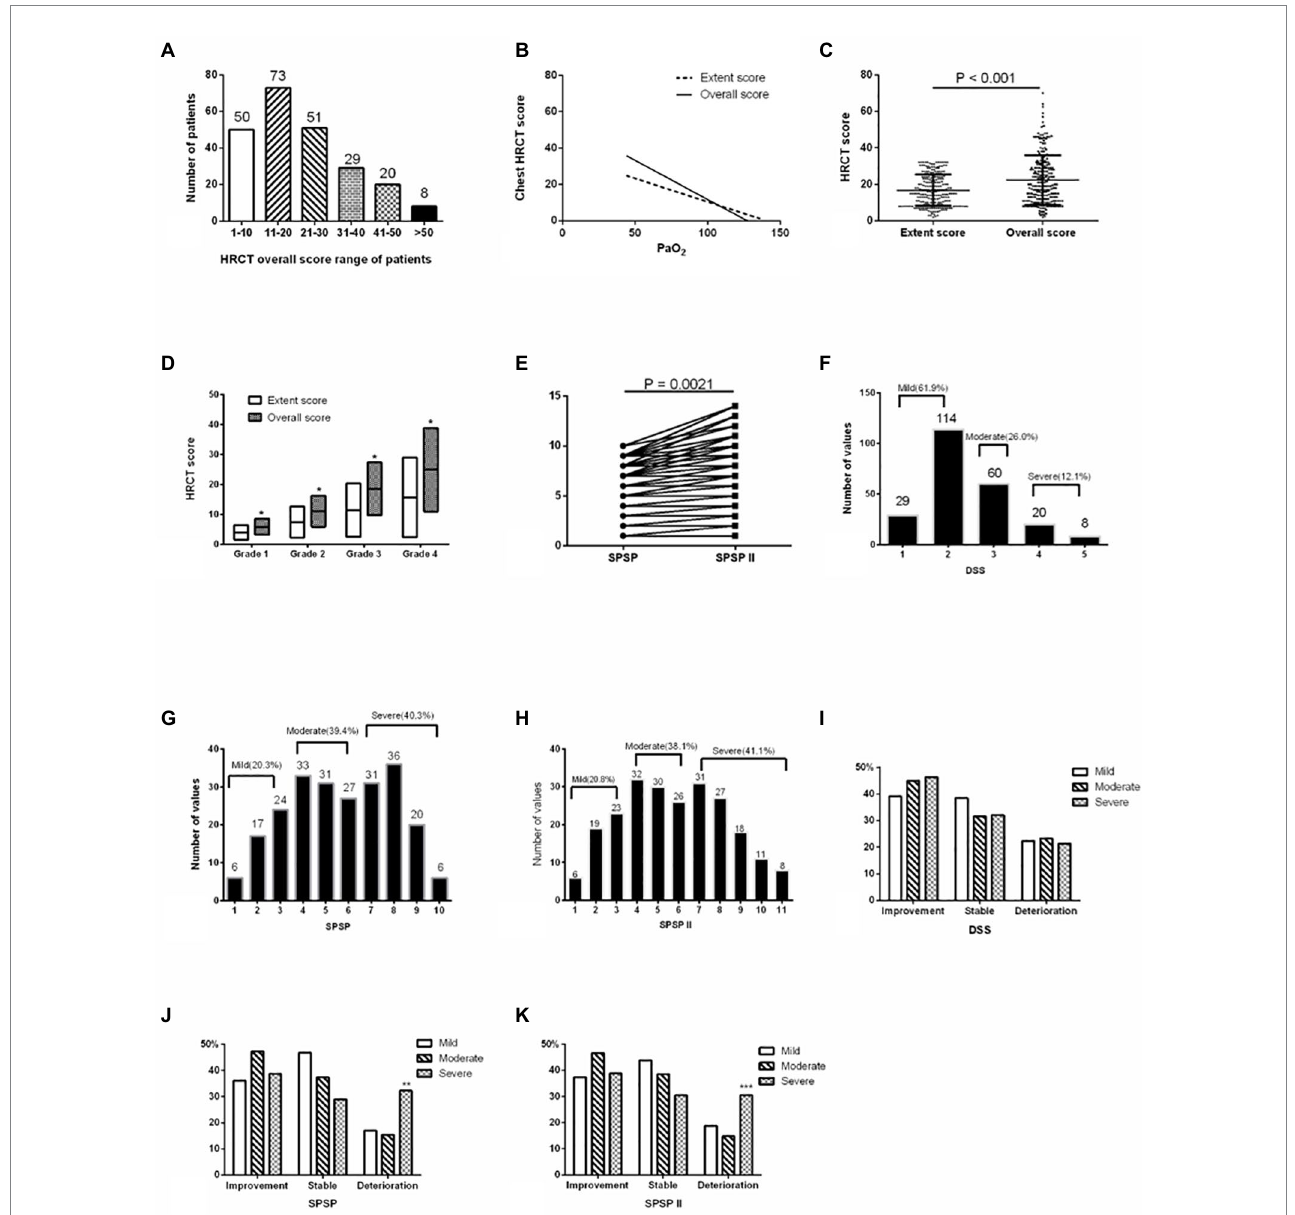
FIGURE 1 Severity assessment of APAP patients in the retrospective study. (A) Overall HRCT score of patients. (B) The correlation between HRCT score and PaO 2 (overall score of HRCT and PaO 2 [ r = − 0.4537, p < 0.001]; extent score of HRCT and PaO 2 [ r = − 0.4366, p < 0.001]). (C) Comparison of the extent and overall scores. (D) Comparison of scores in every grade between extent and overall score (grade 1: ≤ 8; grade 2: >8 and ≤ 16; grade 3: >16 and ≤ 24; grade 4: >24). (E) SPSP and SPSPII of patients. (F) DSS-based severity classification. (G) SPSP-based severity classification. (H) SPSPII-based severity classification. (I)